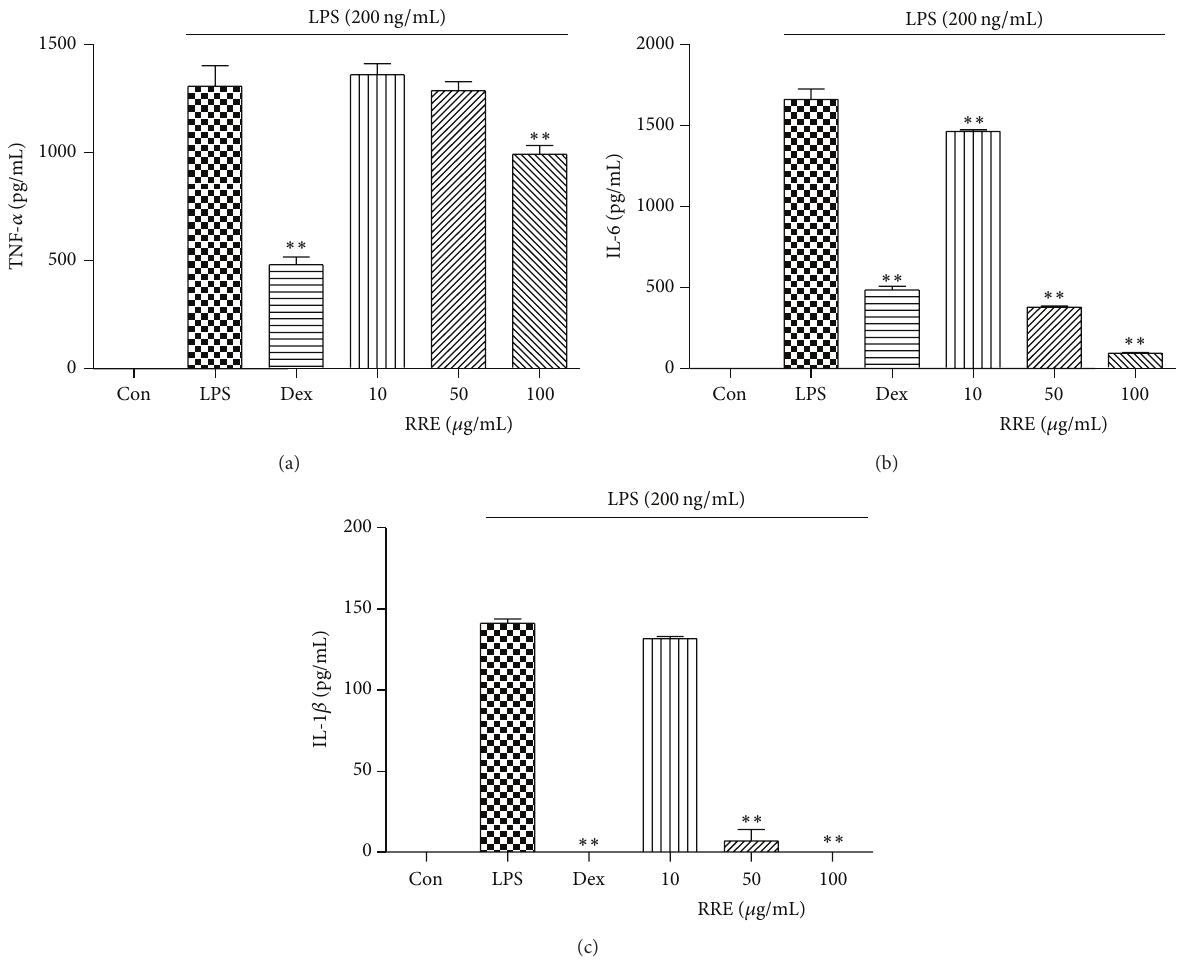
Figure 6: Effect of RRE treatment on the production of (a) TNF- 𝛼 , (b) IL-6, and (c) IL-1 𝛽 cytokines in LPS-stimulated mouse peritoneal macrophages. Cells were treated with RRE for 1h and stimulated with LPS for 24 h. Cytokine production was measured by ELISA. Data represent the mean ± SD of duplicate determinations from three independent experiments. ∗∗ 𝑝 < 0.001 was calculated from comparing with LPS-stimulation